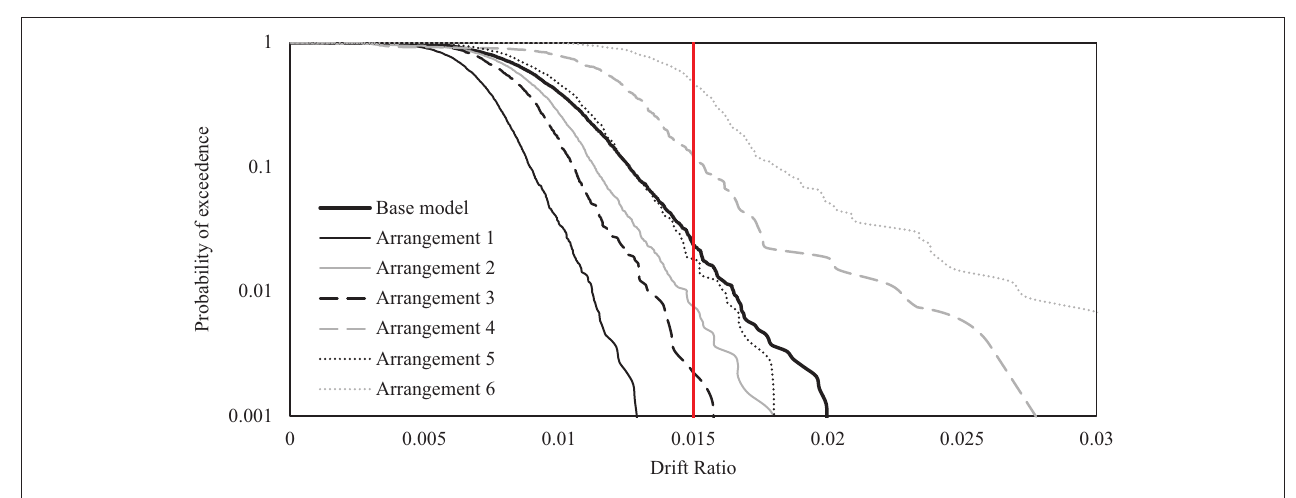
FIGURE 7 | Exceedance probability curves of the drift ratio for all models.